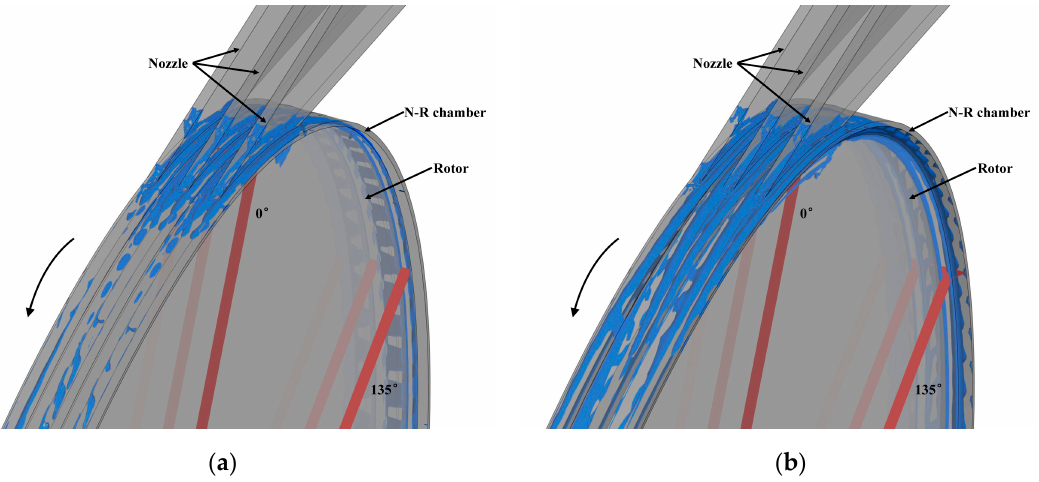
Figure 11. Iso-surface of Q distributions for two turbine models, Q = 4 × 10 8 . ( a ) OTO-B; ( b ) OTO-T-2.